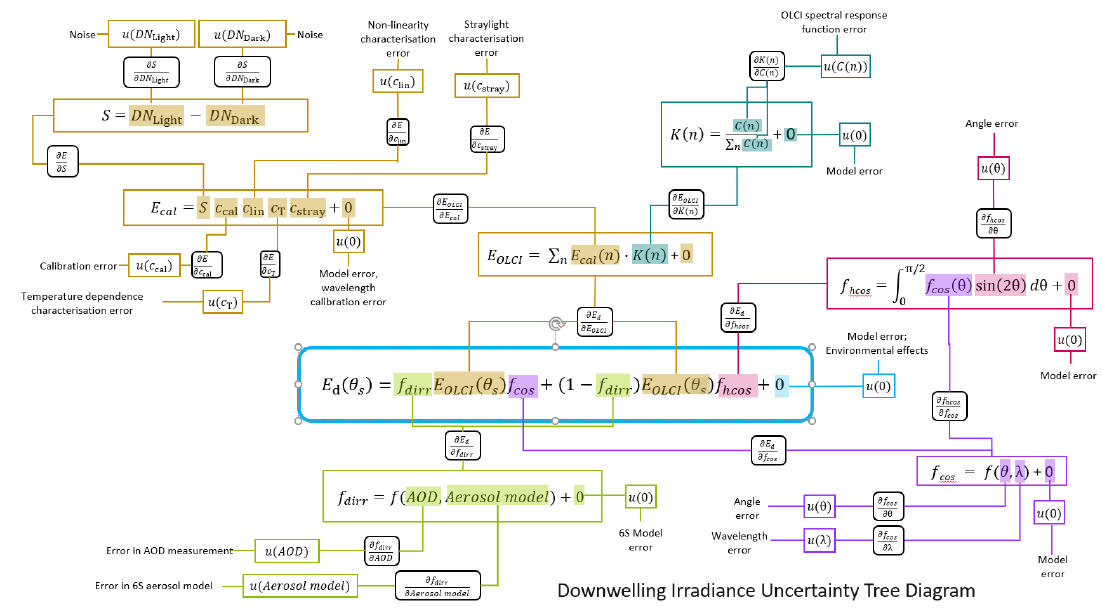
Figure 2. Uncertainty tree diagram for downwelling irradiance.